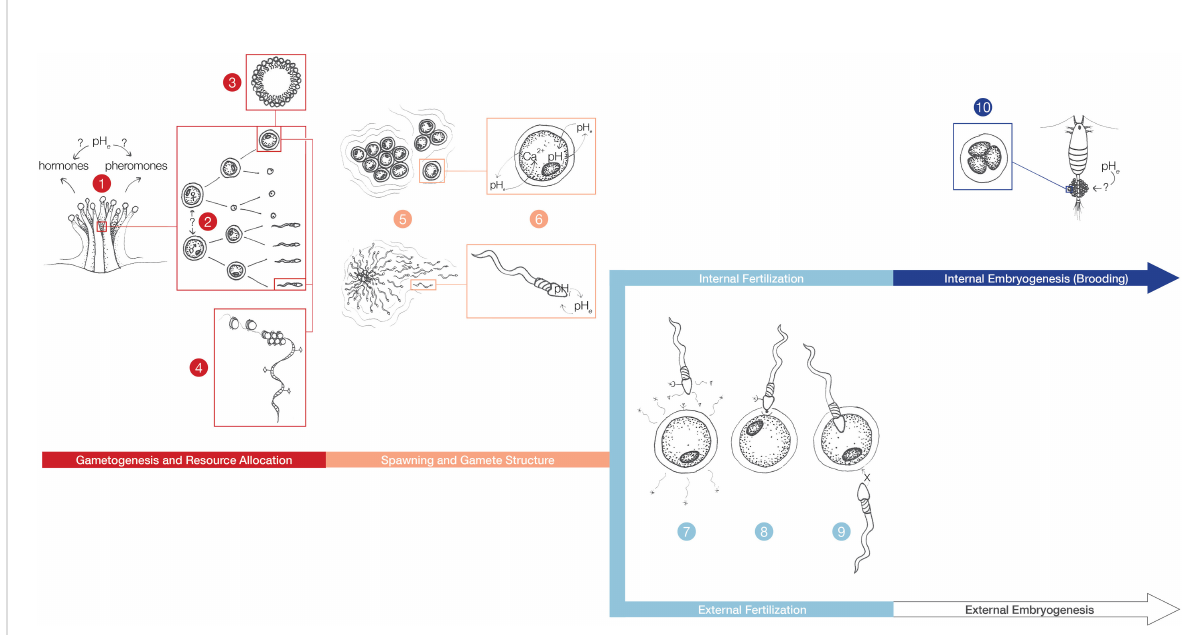
FIGURE 5 Sexual reproduction mechanisms that may be compromised by OA. Changes in the chemical environment can impact the release of hormones and pheromones that trigger gametogenesis, or gamete release in broadcast spawning species (1). Sex determination and differentiation processes (2), gametogenesis timing, and energy allocation (speci fi cally maternal provisioning) (3) can be impacted by low pH. Gametes undergo substantial chromatin reorganization and DNA methylation (4) that can impact how gametes and subsequent offspring respond to acidi fi ed conditions. Spawn timing may be affected by OA (5). Gamete bundles undergo breakage, further exposing gamete intracellular conditions to changes in extracellular pH (pH e ) (6). To begin the fertilization process internally or externally, chemoattractants are released from eggs and sperm (7). A single sperm binds to the egg with the aid of gamete recognition proteins (8). Successful fertilization triggers calcium release or an egg jelly coat to prevent polyspermy (9). Internal embryogenesis can be affected by OA (10). For organisms with internal fertilization, brooding may shield embryo development from changes in pHe or expose embryos to more extreme